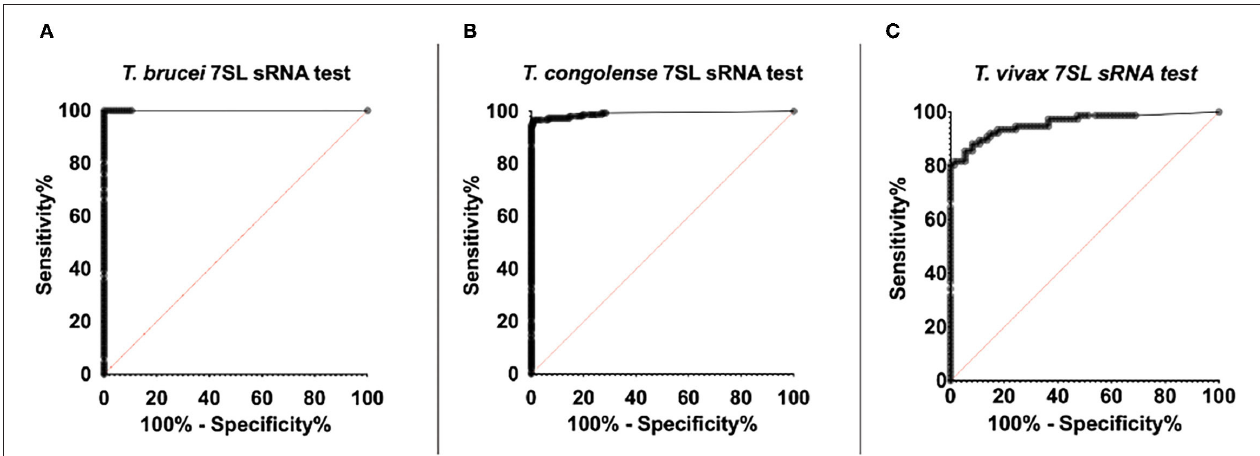
FIGURE 6 | ROC curve of RT-qPCR detection of trypanosome specific 7SL sRNA. ROC analysis was performed using the Wilson/Brown method. The ROC curve of the 7SL sRNA test is represented by the series of black dots. The red diagonal line works as a reference and represents random chance, the characteristics of a test that is not useful for in detecting infection (AUC = 0.5). (A) 107 T. brucei Antat 1.1 infected samples and 104 uninfected samples were included in the analysis (AUC = 1). (B) 153 T. congolense (IL3000 or Kont2/133) infected samples and 123 uninfected samples were included in the analysis (AUC = 0.99). (C) 76 T. vivax STIB 719 infected samples and 74 uninfected samples were included in the analysis (AUC = 0.96).